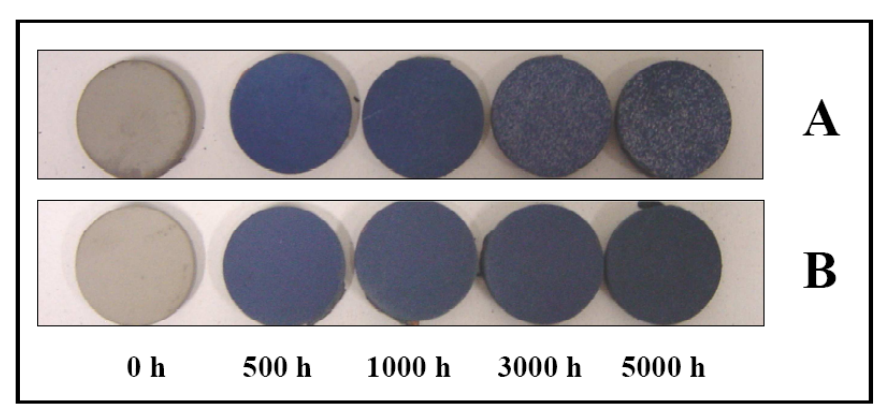
Figure 8. Picture showing the typical appearance of samples A and B before and after different periods of oxidation at 1,273